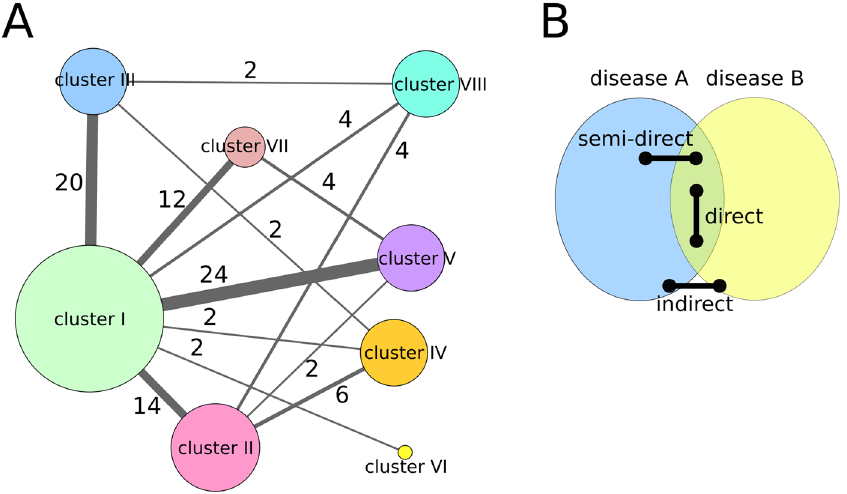
Figure 6. Clusters in the disease network. ( A ) Disease network represented by clusters of diseases. A node corresponds to a cluster of diseases and its size is proportional to its degree. Edges represent inter-cluster relationships and are weighed as the sum of the composite scores over inter-cluster DDAs. Numbers on top of the edges show the number of DDAs connecting the clusters. ( B ) Schematic representation of categorical links between diseases A and B: direct, semi-direct and indirect.